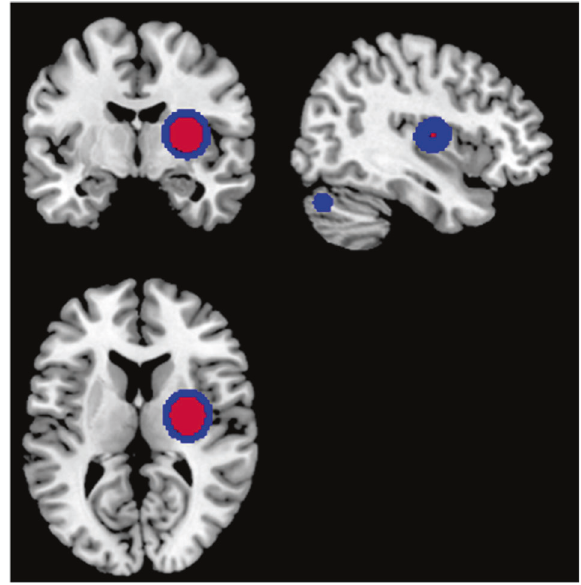
Fig. 5 Visualization of the relevance of the voxels for CHR_T. Classi fi cation of CHR_T as FEP using the difference of entropy in classi fi cation schema (b). The red (cluster 1) and blue (cluster 2) color corresponds to the sorted clusters according to the number of subjects. The smoothed PR with a 7 × 7 × 7 Gaussian kernel is